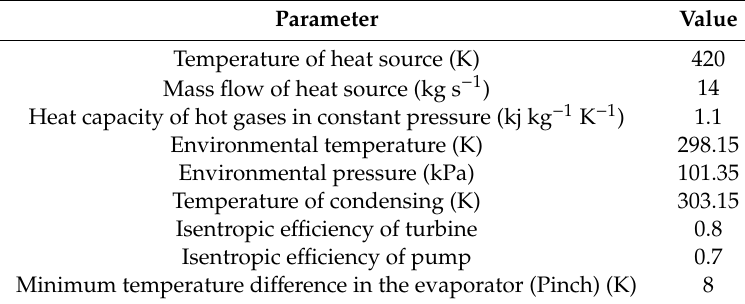
Table 3. Heat source parameters and assumptions [12].